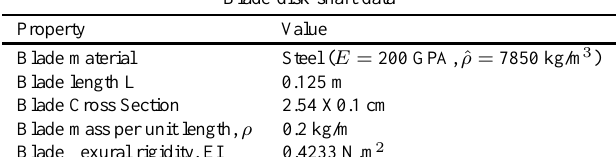
Table 1 Blade-disk-shaft data